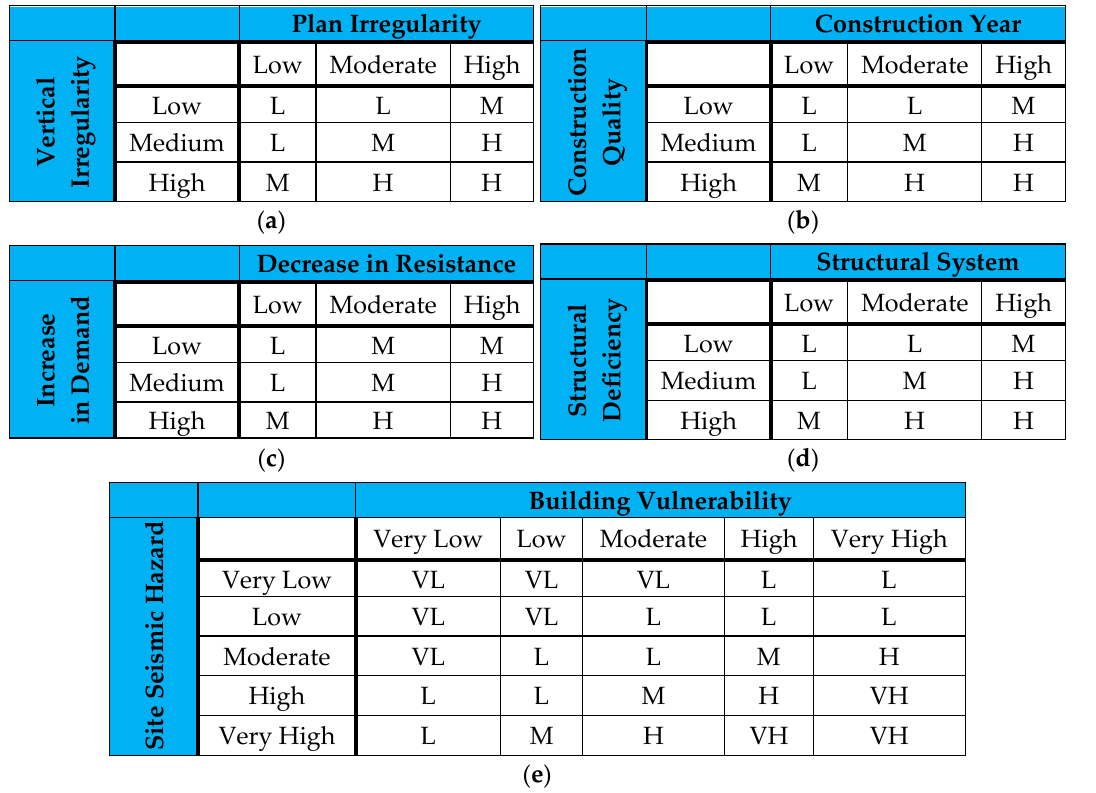
Figure 10. Fuzzy rule base matrix representation of some RVS parameters. ( a ) Increase in demand [9 rules]; ( b ) Decrease in resistance [9 rules]; ( c ) Structural deficiency [9 rules]; ( d ) Building vulnerability [9 rules]; ( e ) Building damageability [25 rules].